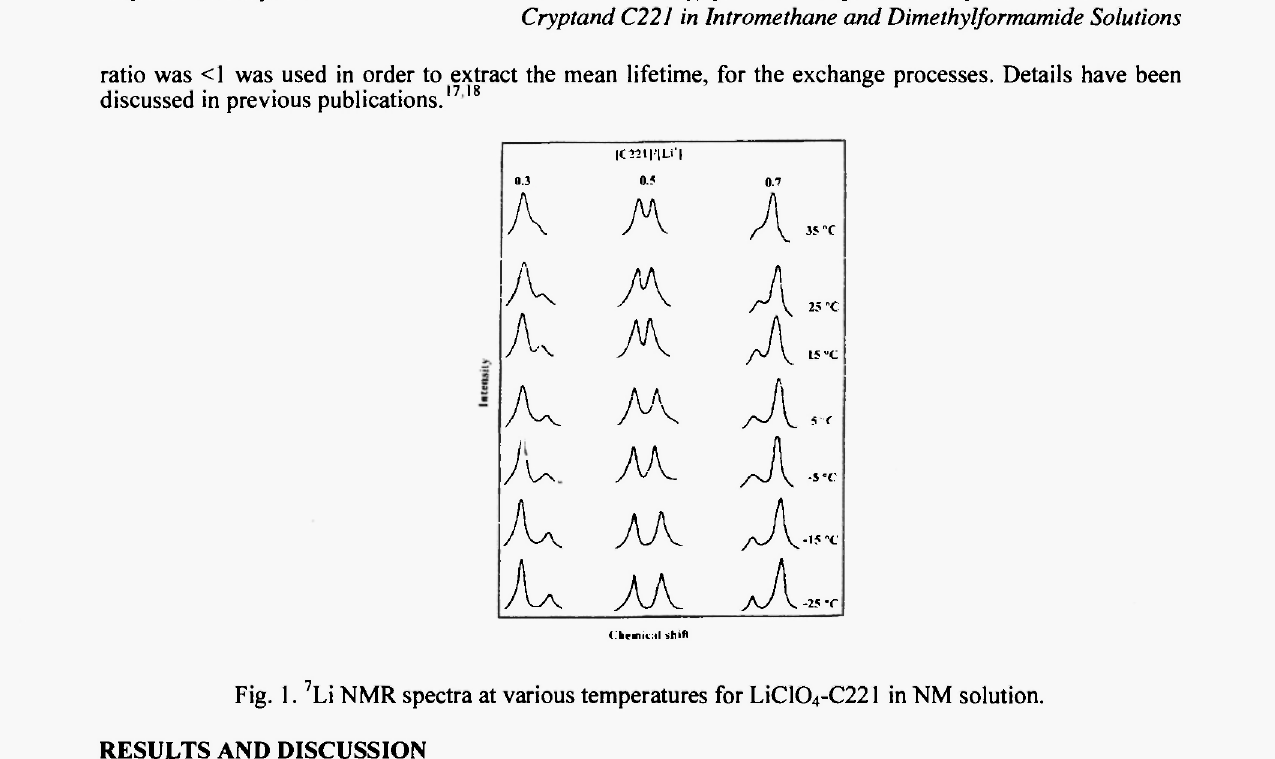
Fig. 1. 7 Li NMR spectra at various temperatures for LiC10 4 -C221 in NM